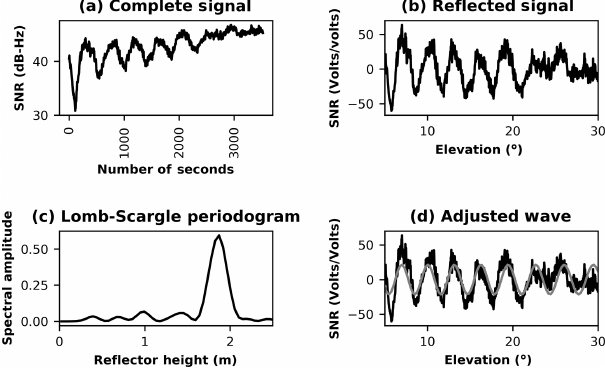
Figure 5. GPS satellite no. 23 observed with the geodetic antenna. SNR data in volts (a) , SNR data with the direct signal removed (b) , Lomb–Scargle periodogram for the SNR reflected signal (c) , and SNR reflected signal with the adjusted wave (d) .